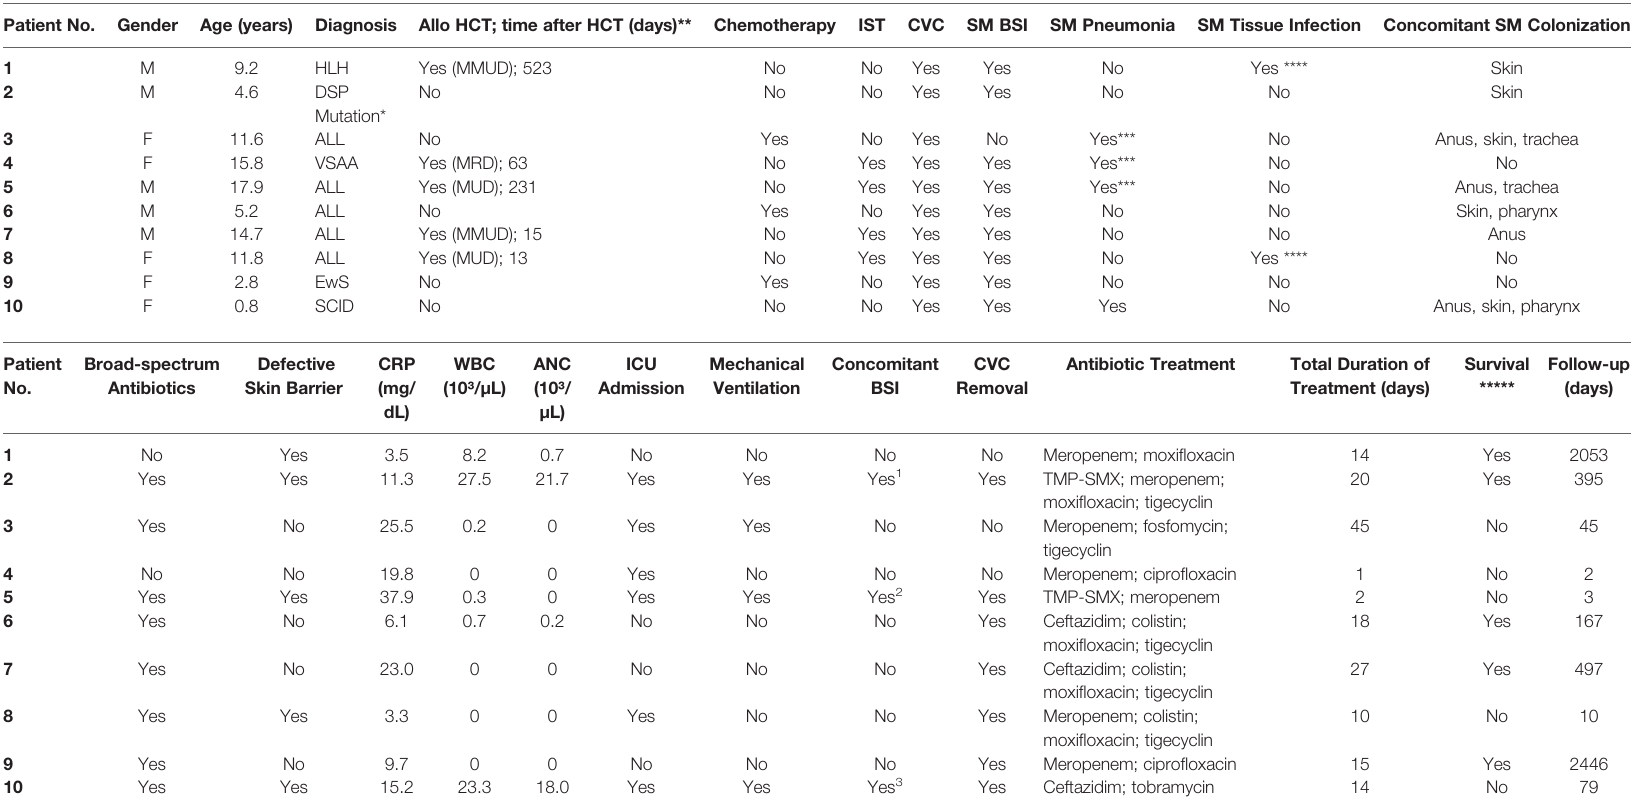
TABLE 1 | Demographics, underlying condition and principal treatment, central venous cannulation, infection and colonization data, concomitant clinical data, treatment and outcome of ten pediatric patients with oncological or hematological disease including patients with autologous or allogeneic hematopoietic cell transplantation and invasive S.maltophilia infections.